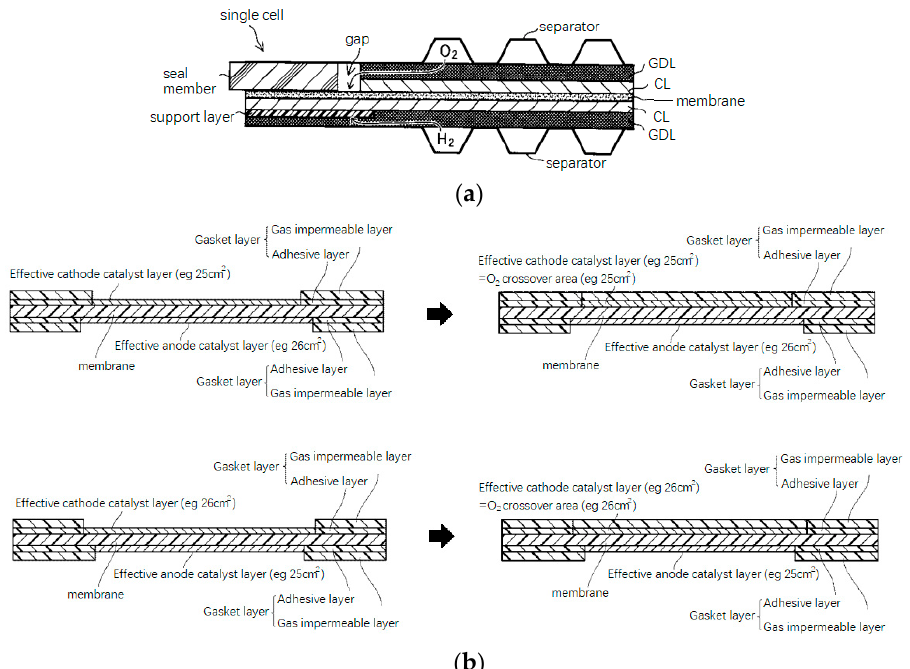
Figure 8. Misalignment of cathode and anode catalysts at the edges of membrane electrodes may aggravate chemical degradation. ( a ) Gap at the joint of the active area and the frame [78]. ( b ) As the area of the cathode catalyst increases, the oxygen passage area becomes larger [79].